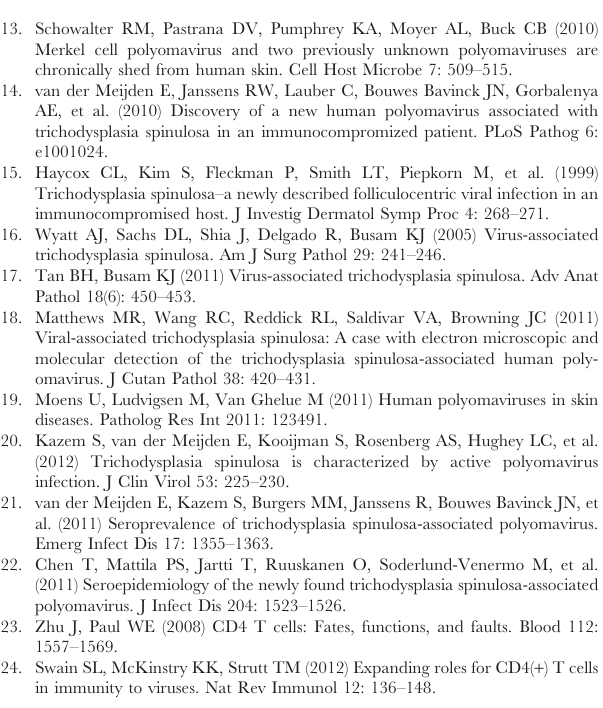
Figure S1 (A) Effect of MCV-specific IgG level on Th-cell responses and (B) comparison of MCV-specific IFN- c and IL-10 responses among low and high MCV-IgG and MCV-seronegative groups. Table S1 Comparison of MCV-specific IFN- c and IL-10 responses among 24 MCV-seropositive and 27 seroneg- ative subjects against 0.5 and 1.5 m g/ml MCV VP1 and Candida albicans (2.5 m g/ml) antigen concentration.